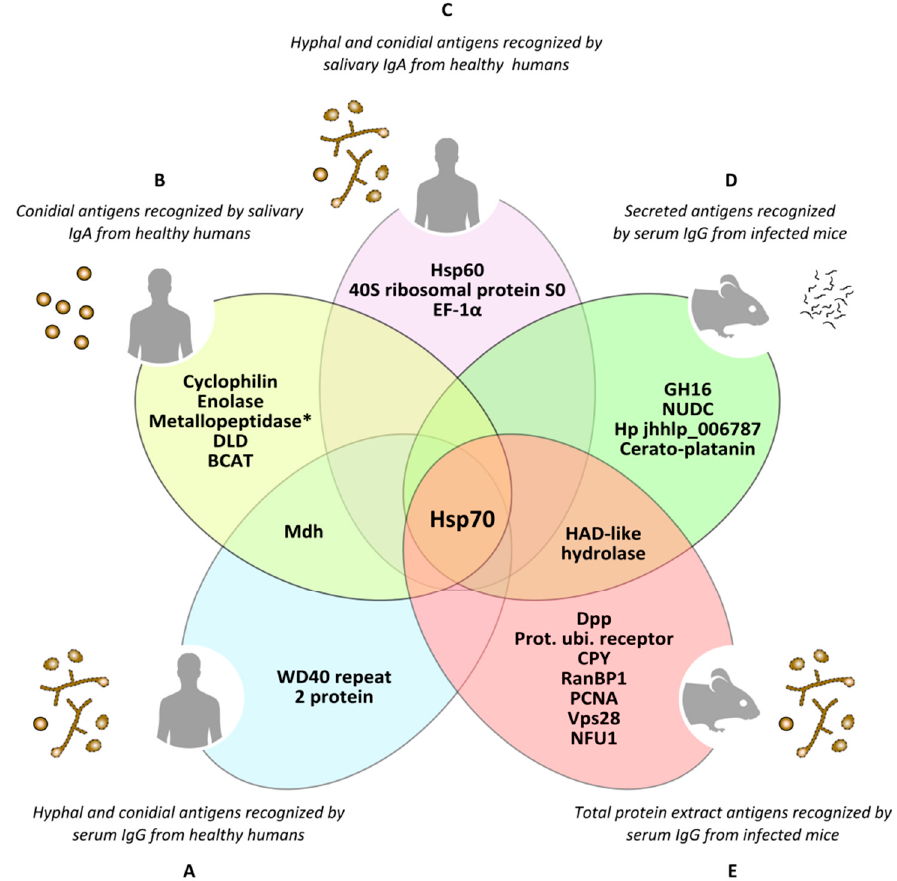
Figure 4. Antigens of Lomentospora prolificans identified in several immunoproteomics-based studies. Antigens detected as being reactive against at least 70% of human serum samples in both hyphal and conidia morphologies ( A ). Conidial antigens that reacted with at least 50% of human salivary samples ( B ). The most immunodominant antigens that react with human salivary samples, detected in both fungal morphologies ( C ). The most immunodominant antigens of secretome ( D ) and total protein extract ( E ) recognized by sera from infected mice. Mdh: malate dehydrogenase; Hsp70: heat shock protein 70; Metallopeptidase: Cys-Gly metallo-dipeptidase DUG1; DLD: dihydro-lipoyl dehydrogenase; BCAT: putative branched-chain-amino-acid aminotransferase TOXF; Hsp60: heat shock protein 60; EF-1 α : translation elongation factor-1 α ; GH16: glycosyl hydrolase family 16 protein; NUDC: nuclear movement protein nudC; Hp jhhlp_006787: protein with unknown function Hp jhhlp_006787; HAD-like hydrolase: halo-acid dehalogenase-like hydrolase; Dpp: dipeptidyl- peptidase; Prot. ubi. receptor: Proteasomal ubiquitin receptor; CPY: carboxypeptidase Y; RanBP1: RanBP1 domain-containing protein; PCNA: proliferating cell nuclear antigen; Vps28: vacuolar protein sorting-associated protein 28; NFU1: NFU1 iron-sulfur cluster scaffold-like protein. * This antigen has been added by repeating the peptides spectra analysis with a later version of the NCBI (National Center for Biotechnology Information)